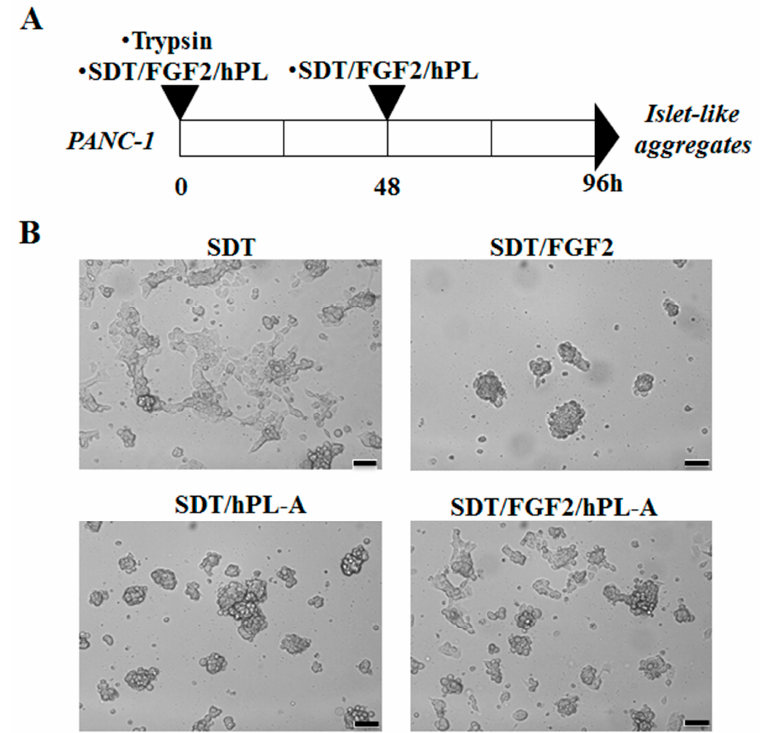
Figure 1. Induction of human pancreatic ductal-cells (PANC-1) differentiation towards islet-like aggregates. PANC-1 cells were treated with 50% trypsin for 30 s and incubated with serum-free medium supplemented with 0.1% bovine serum albumine (BSA) plus 1.1 mg/L transferrin (SDT). SDT medium was then supplemented with 500 ng/mL human fibroblast growth factor (FGF)-2b or 500 ng/mL human placental lactogen (hPL)-A, or with both hormones (FGF-2b plus hPL-A). Treatments were refreshed after 48 h, according to the scheme shown in ( A ). After 96 h, PANC-1 cells differentiated into islet-like aggregates ( B ). Scale bar = 100 μ m.